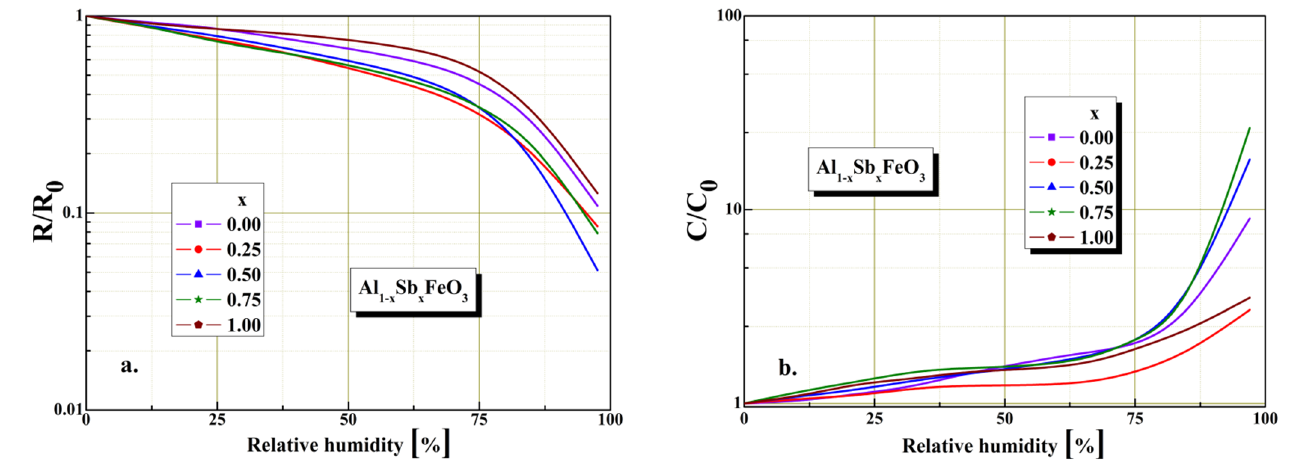
Figure 9. Humidity sensitivity of resistive and capacitive sensors based on Al 1 − x Sb x FeO 3 perovskite material: ( a ) electrical resistance in normalized form ( b ) electrical capacitance in normalized form.